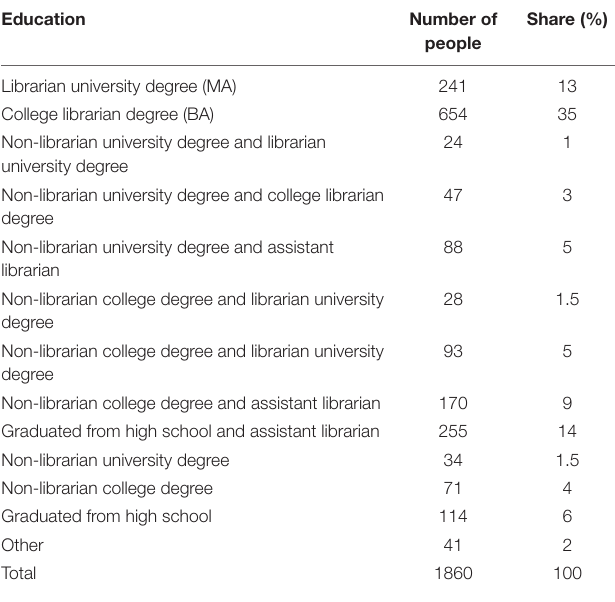
TABLE 1 | Distribution of respondents by education.